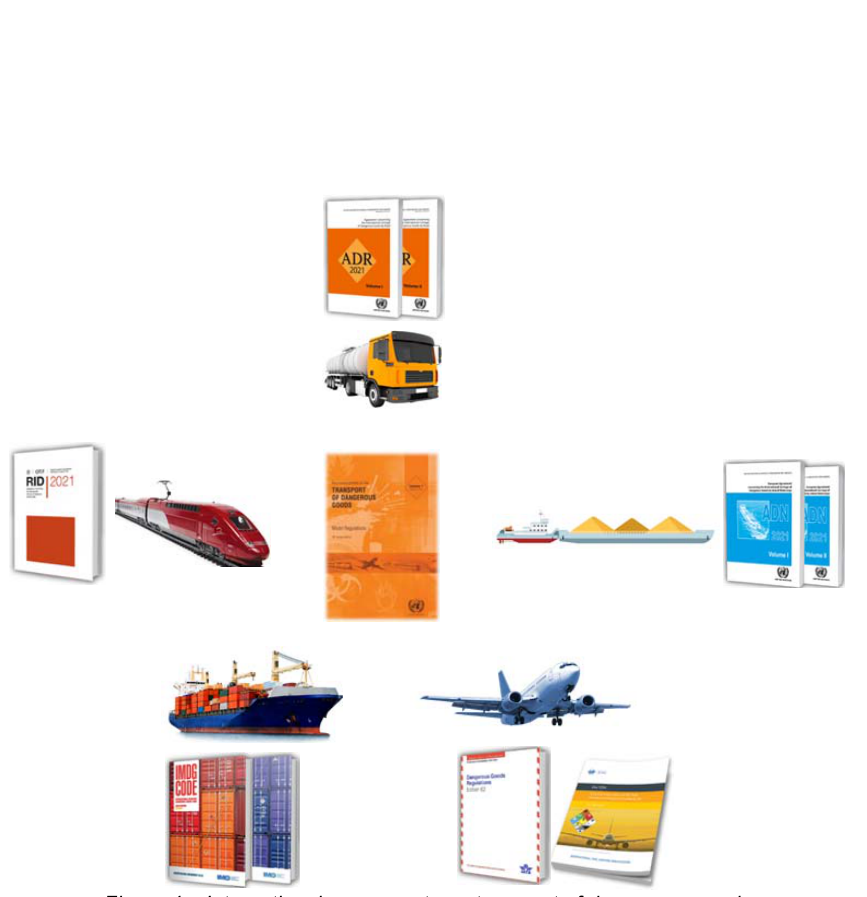
Figure 4 – International agreements on transport of dangerous goods Pu с . 4 – Международные соглашения по перевозке опасных грузов Слика 4 – Међунардни споразуми о транспорту опасне